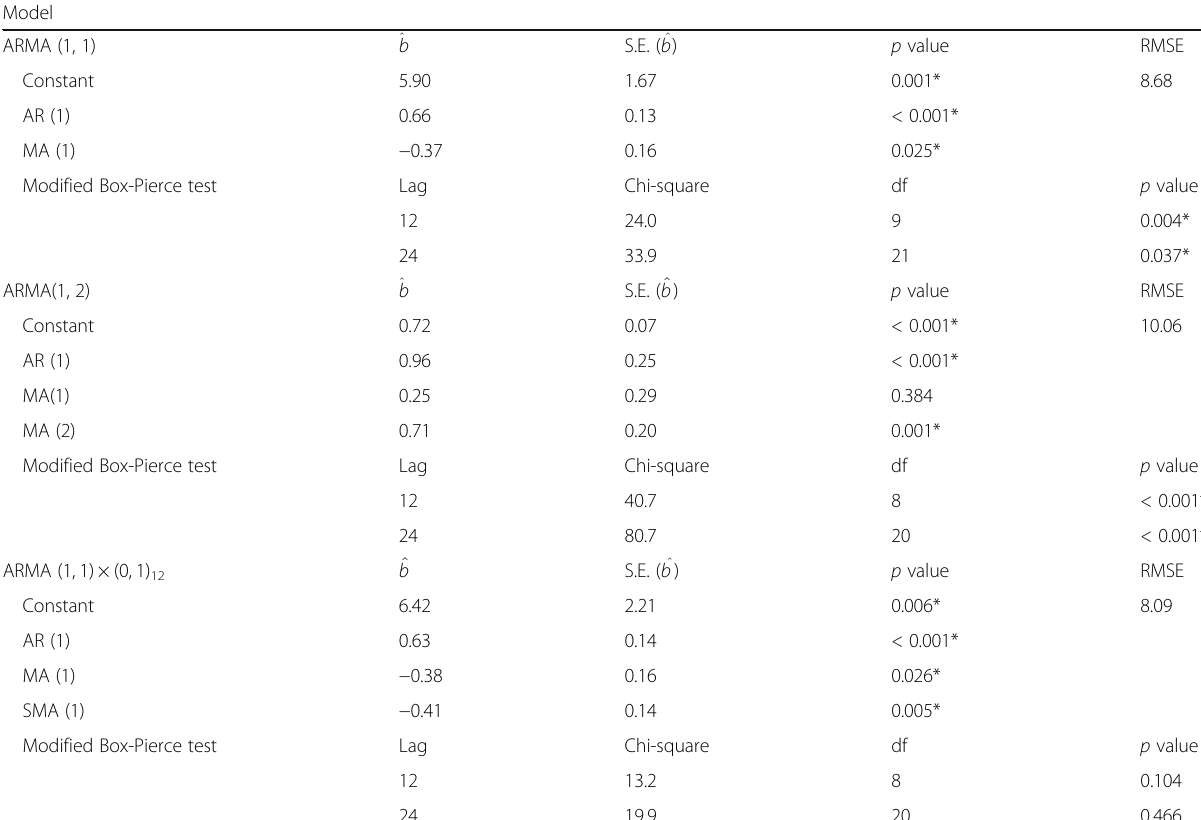
Table 6 Three candidate processes for the study population via time series models per year